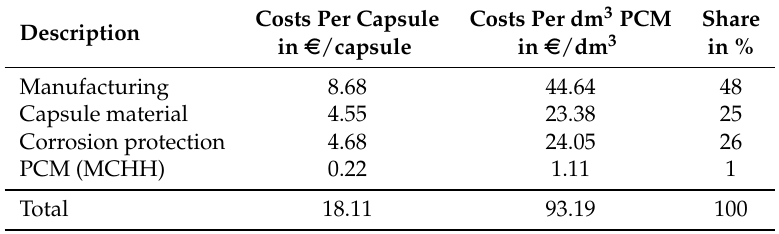
Table 2. Estimated costs for the proposed macro-capsules. The costs for manufacturing, capsule material and corrosion protection are based on the invoices for the production and the costs of the PCM are taken from a previous publication